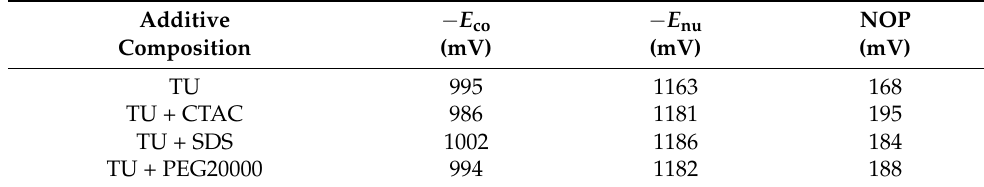
Table 1. Effect of additives on the cross overpotential ( E co ), nucleation potential ( E nu ) and nucleation overpotential (NOP) of nickel